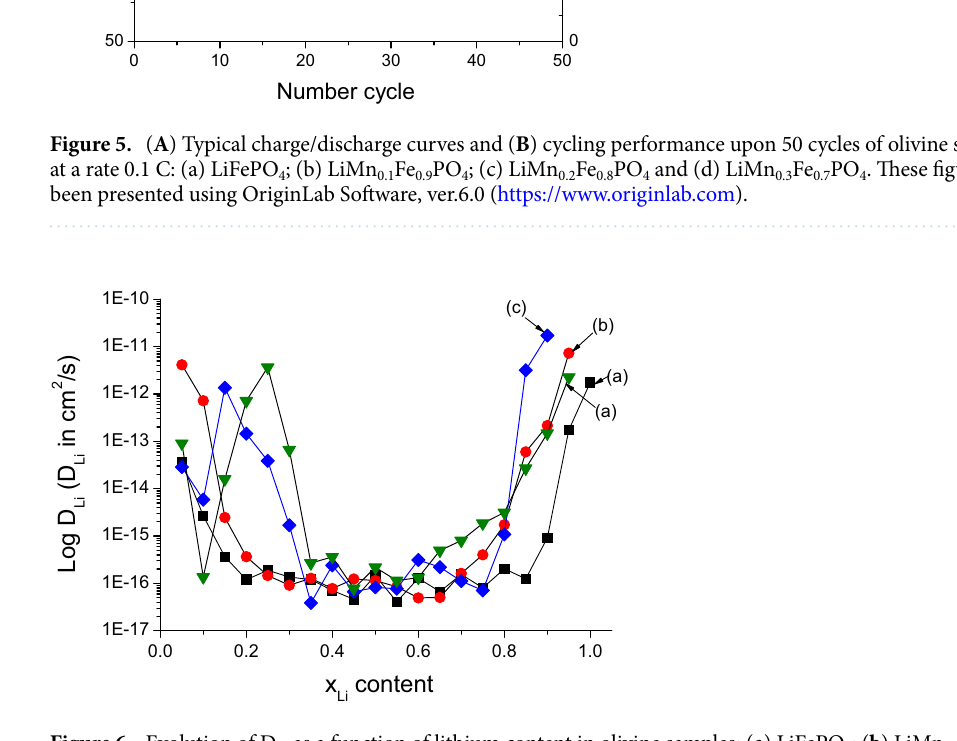
Figure 6. Evolution of D Li as a function of lithium content in olivine samples: ( a ) LiFePO 4 ; ( b ) LiMn 0.1 Fe 0.9 PO 4 ; ( c ) LiMn 0.2 Fe 0.8 PO 4 and ( d ) LiMn 0.3 Fe 0.7 PO 4 . These figures have been presented using OriginLab Software, ver.6.0 (https:// www. origi nlab.